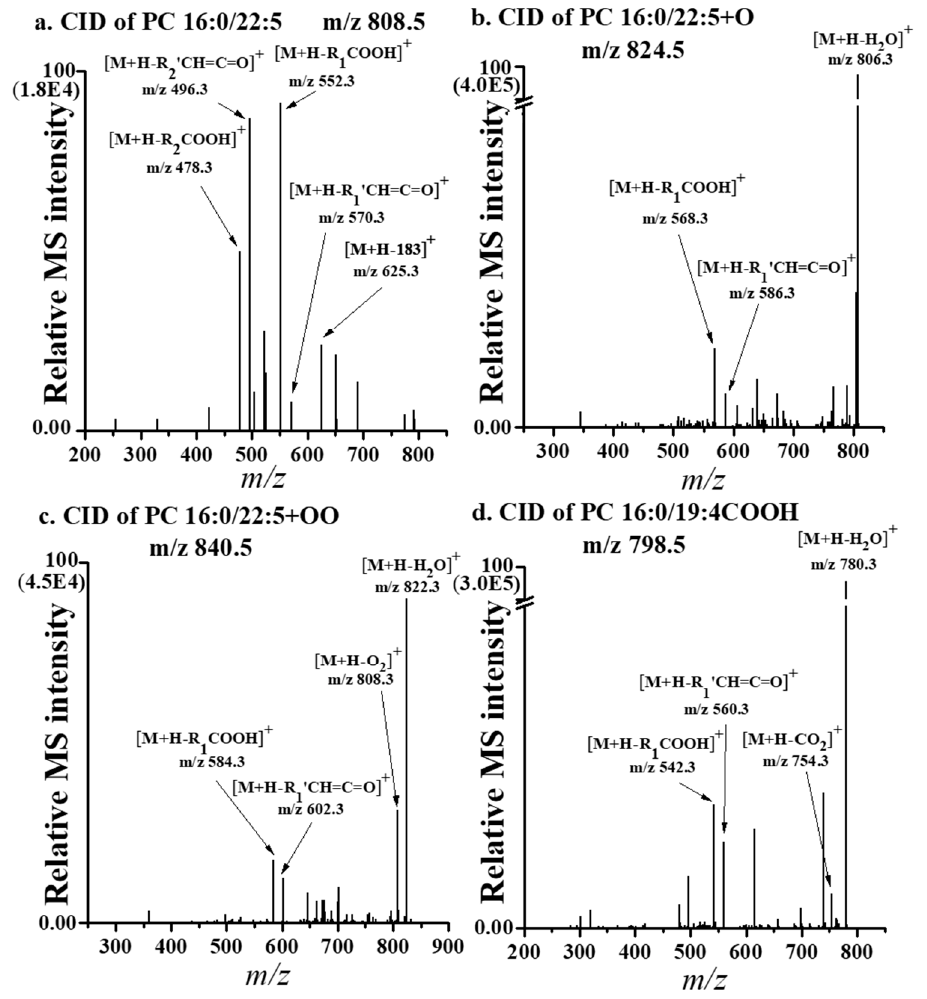
Figure 6. CID spectra of ( a ) intact PC 16:0 / 22:5 and oxidized products ( b ) PC 16:0 / 22:5 + O, ( c ) PC 16:0 / 22:5 + OO, and ( d ) PC 16:0 / 19:4COOH. Table 1. Fold ratio [PMOp/control (P/C)] of oxidized phospholipids identified in the LDL fraction obtained by nUHPLC–ESI–MS/MS. Underlined species represent the chain structure of intact molecules, and species in boldface represent >1.5-fold change. * = p < 0.05 and ** = p < 0.01.